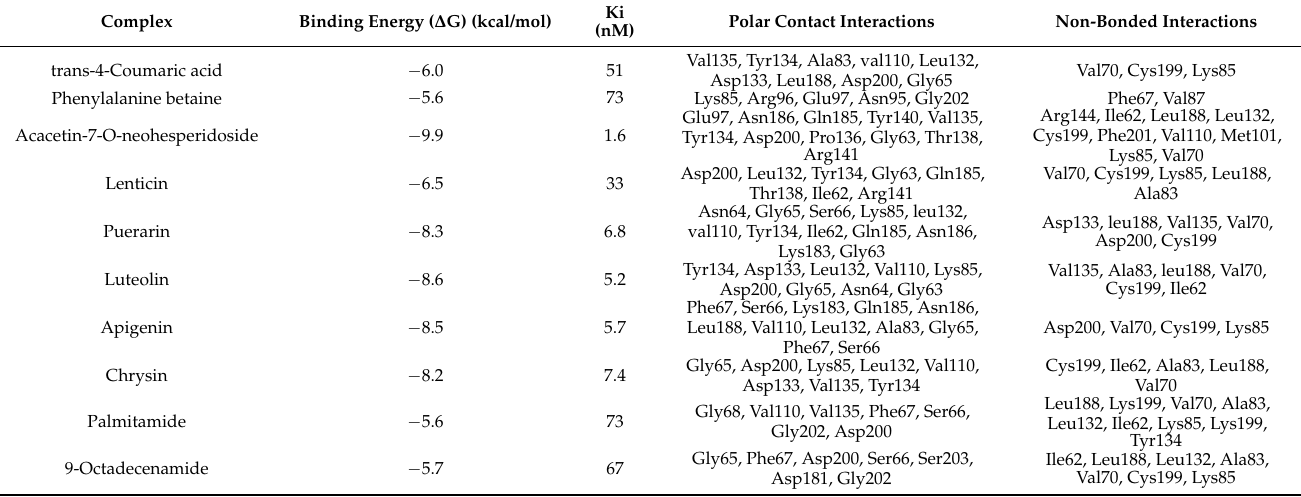
Table 3. Binding energy, predicted inhibitory concentration profile, and residue interactions between ligands and glycogen synthase kinase 3 β (PDB IDs: